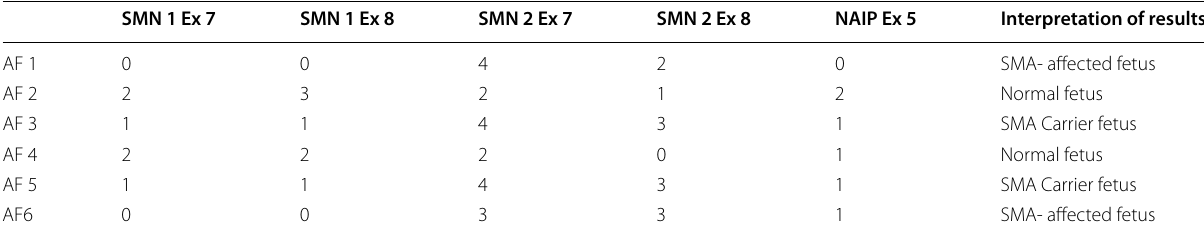
Table 2 Number of copies of SMN1 , SMN2 and NAIP gene detected by MLPA in 6 amniotic fluid